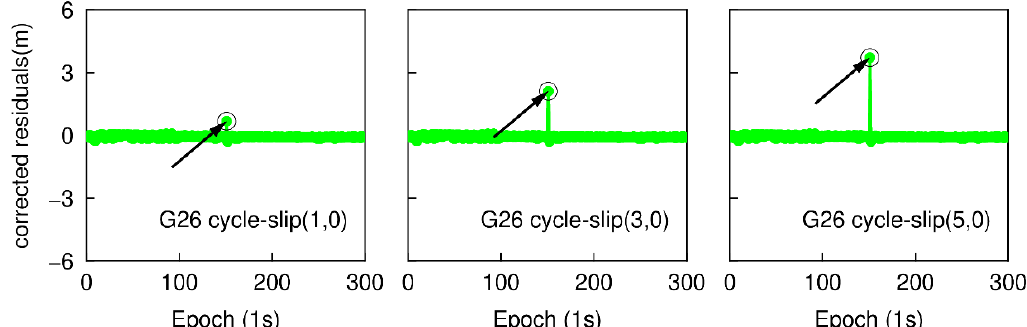
Figure 7. Small cycle-slip detection results by checking the largest residual for G26.